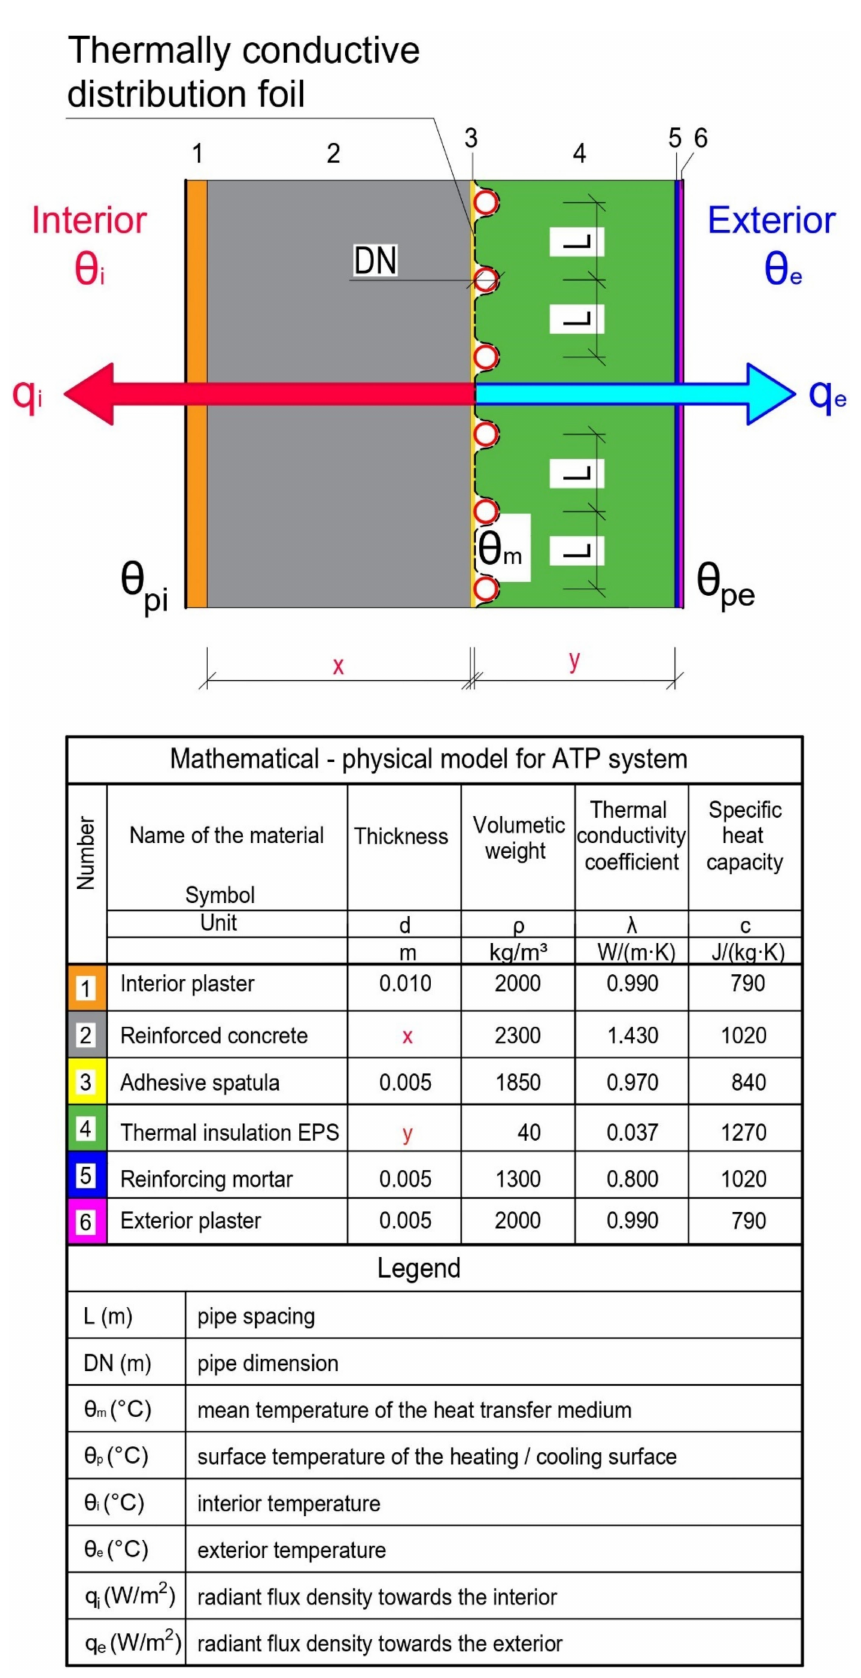
Figure 17. Mathematical-physical model of a perimeter wall with a thermal insulation panel with integrated active thermal